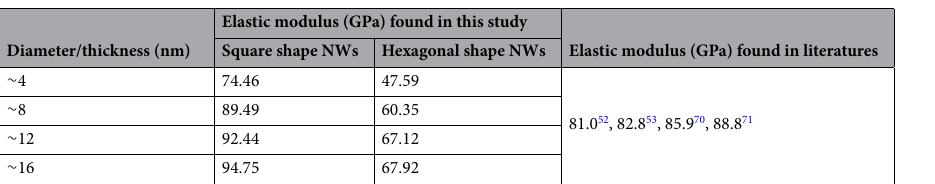
Elastic modulus (GPa) found in this Diameter/thickness (nm)